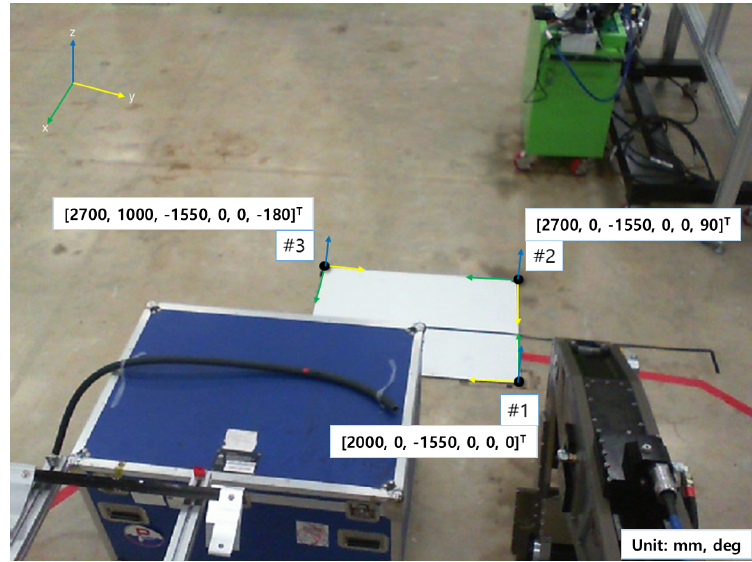
Figure 8. Setup for position estimation